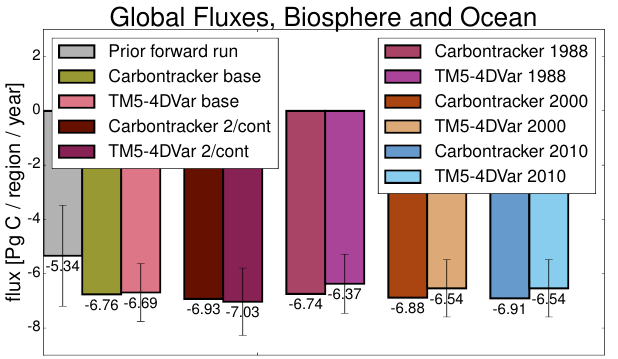
Figure 13. Fluxes for CarbonTracker and TM5-4DVar from April 2009 to April 2010 separated into the two Transcom regions in North America.